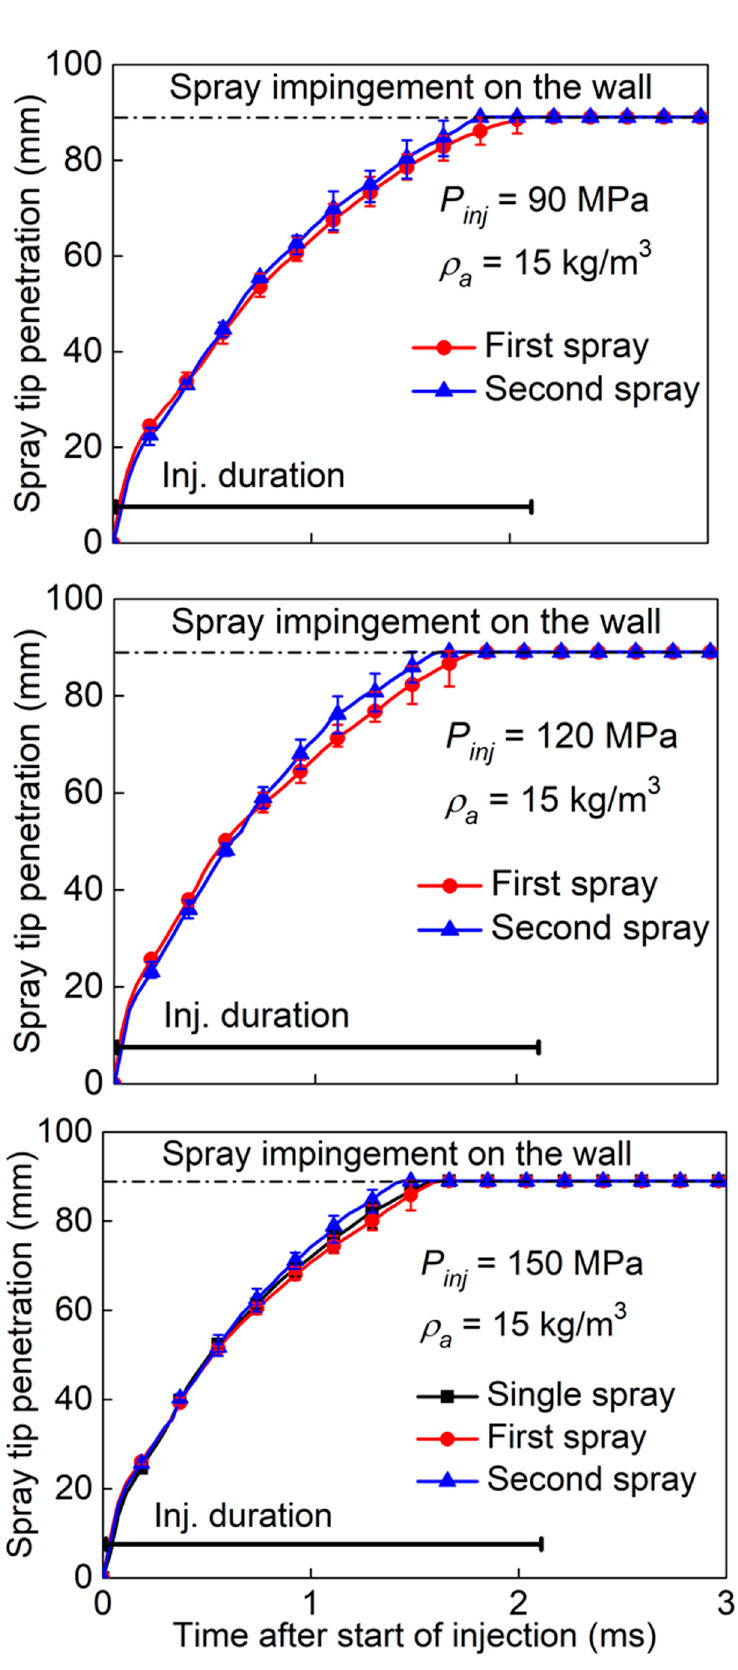
Figure 20. Comparing results of spray tip penetration between the first spray and second spray under various injection pressure.